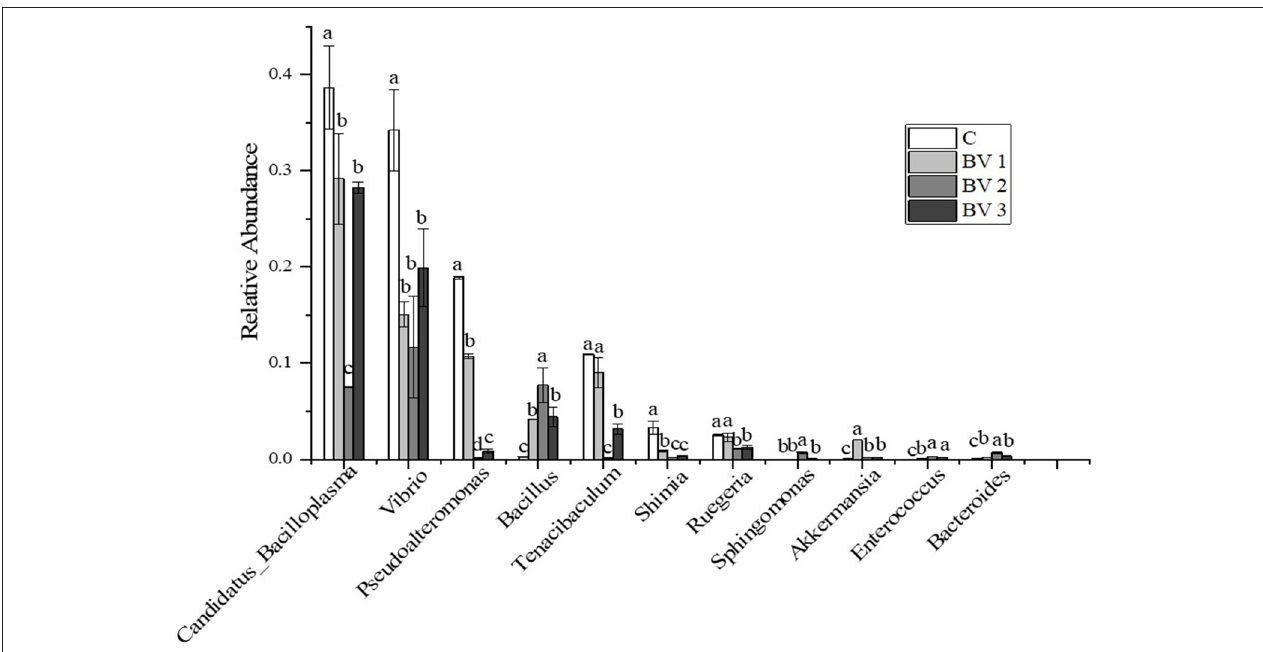
FIGURE 5 | Relative abundance of the top 10 classes at the genus level of intestinal microflora of L. vannamei fed diets containing 0 CFU/g (C), 10 5 CFU/g (BV1), 10 7 CFU/g (BV2), or 10 9 CFU/g (BV3) B. velezensis . Error bars with different letters (a, b, c) represent statistically significant differences based on the LSD method ( P < 0.05, one-way ANOVA). The results were shown as mean ± SE ( N = 3).